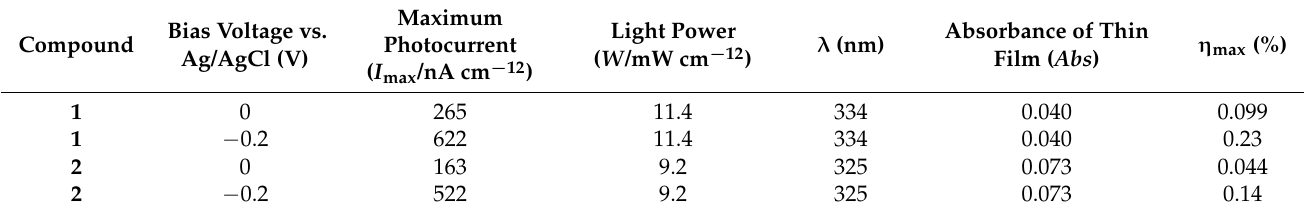
Table 3. Estimation of maximum photoelectric conversion efficiency ( η max ) of the thin film samples of complexes 1 and 2 .